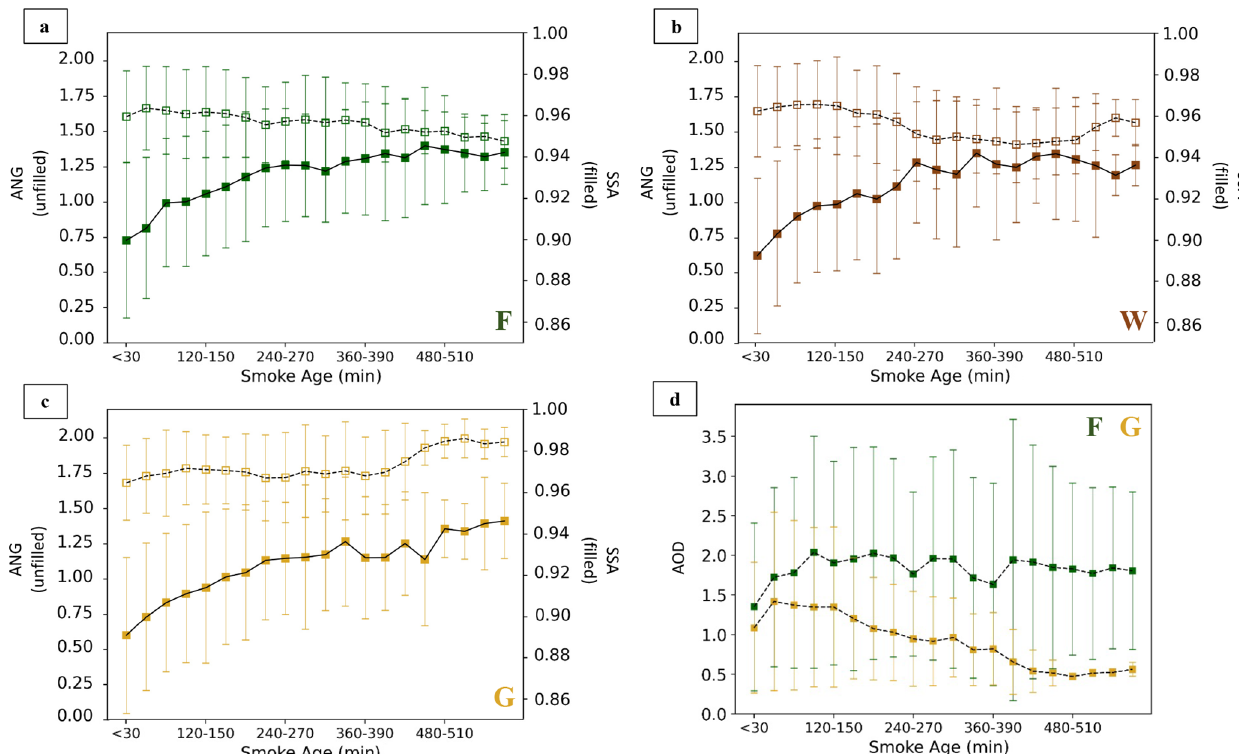
Figure 4. MISR mid-visible Ångström exponent (unfilled markers, dotted lines, left vertical axes) and single-scattering albedos (filled markers, solid lines, right vertical axes) by smoke age for (a) Forest plumes, (b) Woody plumes, and (c) Grassy plumes. (The fuel type is indicated in the lower right-hand corner of these plots.) In panel (d) , the MISR mid-visible AOD is plotted by age for forest and grassy plumes. The points represent the mean values, and the whiskers are standard